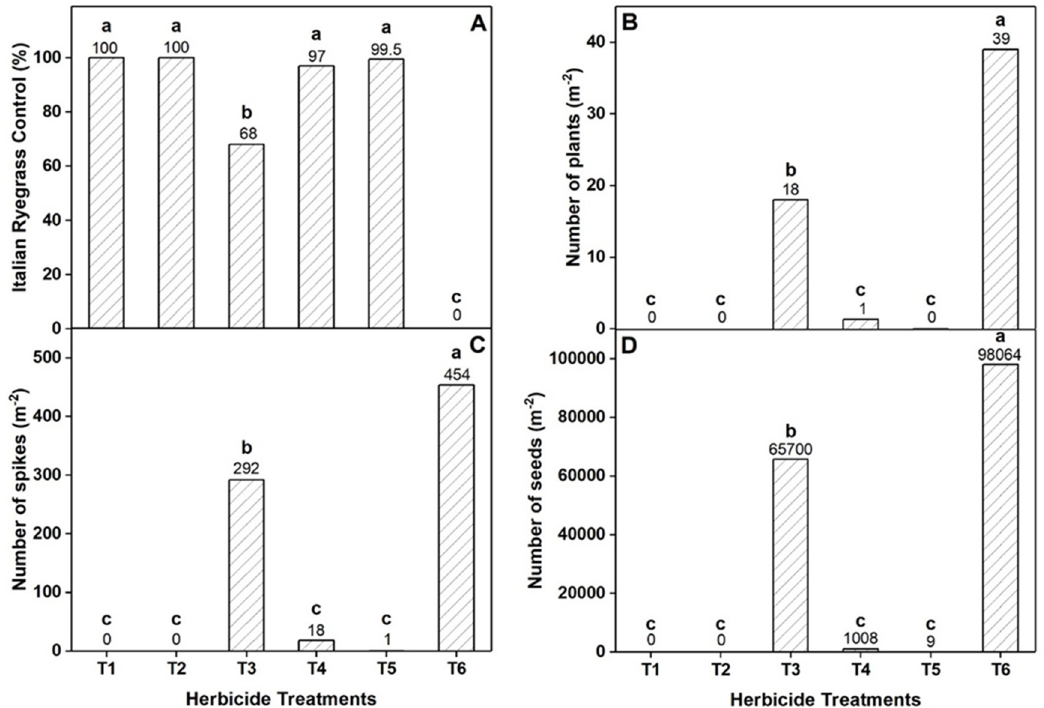
Figure 3. Glyphosate-resistant Italian ryegrass seed suppression study in 2017 showing percent weed − 2 ( B ), number of spikes m − 2 ( C ), and number of seeds m − 2 ( D control ( A ), number of plants m –2 ( B ), number of spikes m –2 ( C ), and number of seeds m –2 ( D ). control ( A ), number of plants m